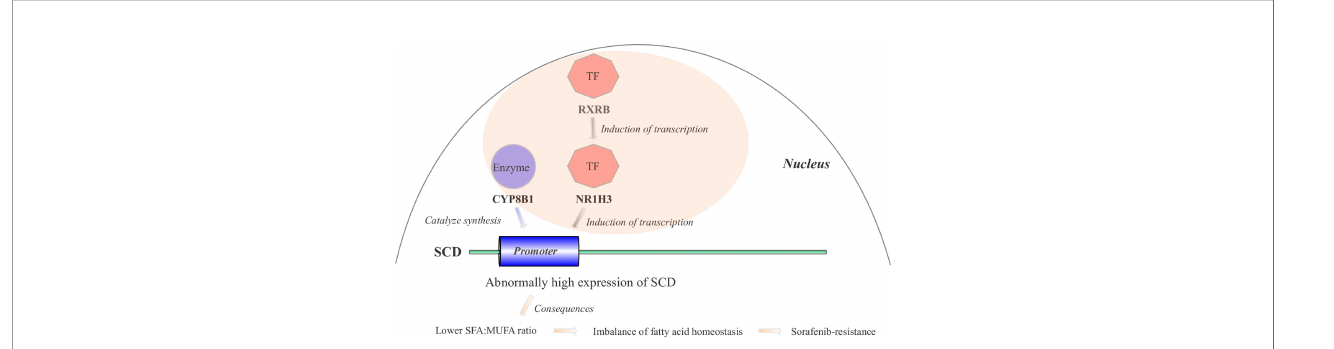
FIGURE 6 | The mechanistic hypothesis for four hub genes in the PPAR signaling pathway. Abnormally high expression levels of four hub genes result in sorafenib resistance through a cascade reaction in the PPAR